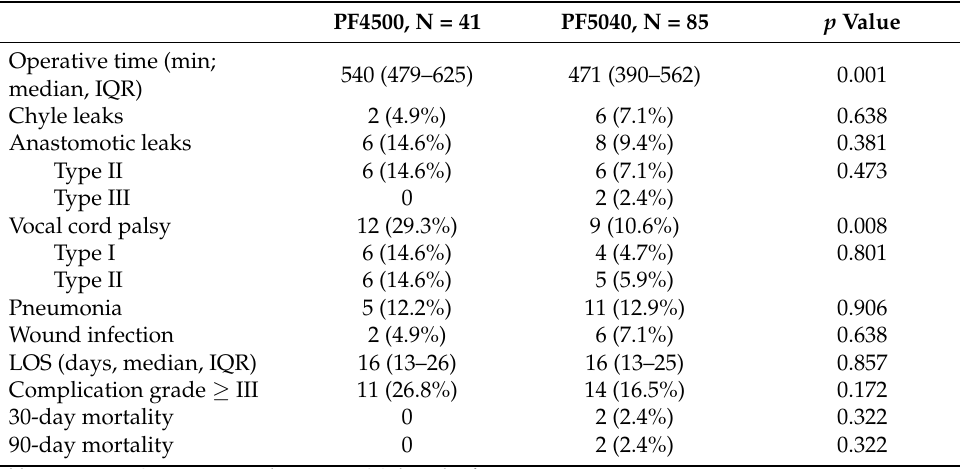
Table 5. Perioperative outcomes of patients in PF4500 and PF5040 group.